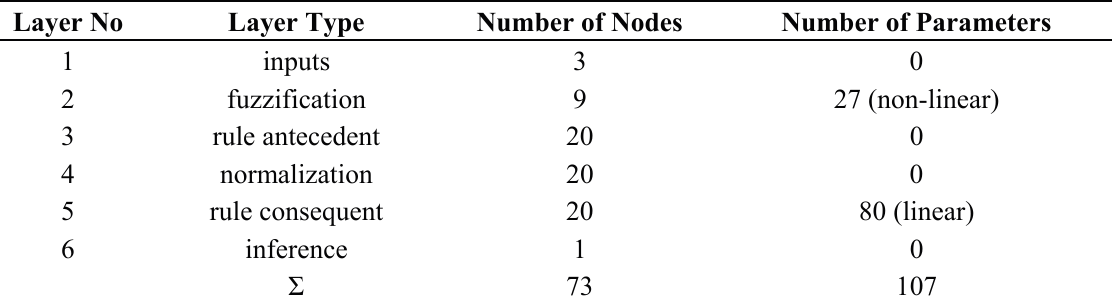
Table 5. The summary of the proposed